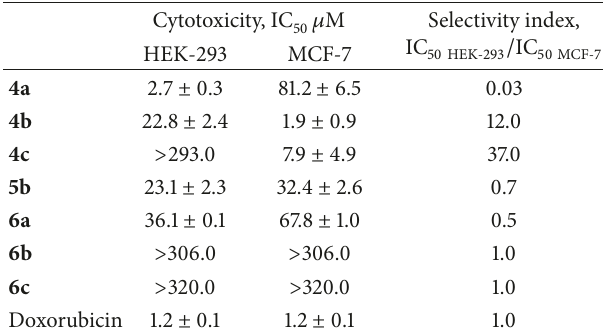
Table1:Resultsofthecytotoxicityscreeningexperimentagainsttwo